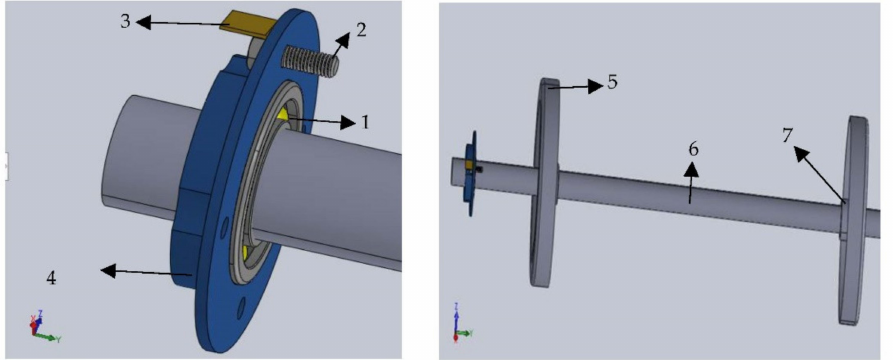
Figure 6. CAD modal of components: 1. Bearing, 2. Bolt, 3. Bracket, 4. Housing, 5. Threshing disk, 6. Threshing shaft, 7. Hub.